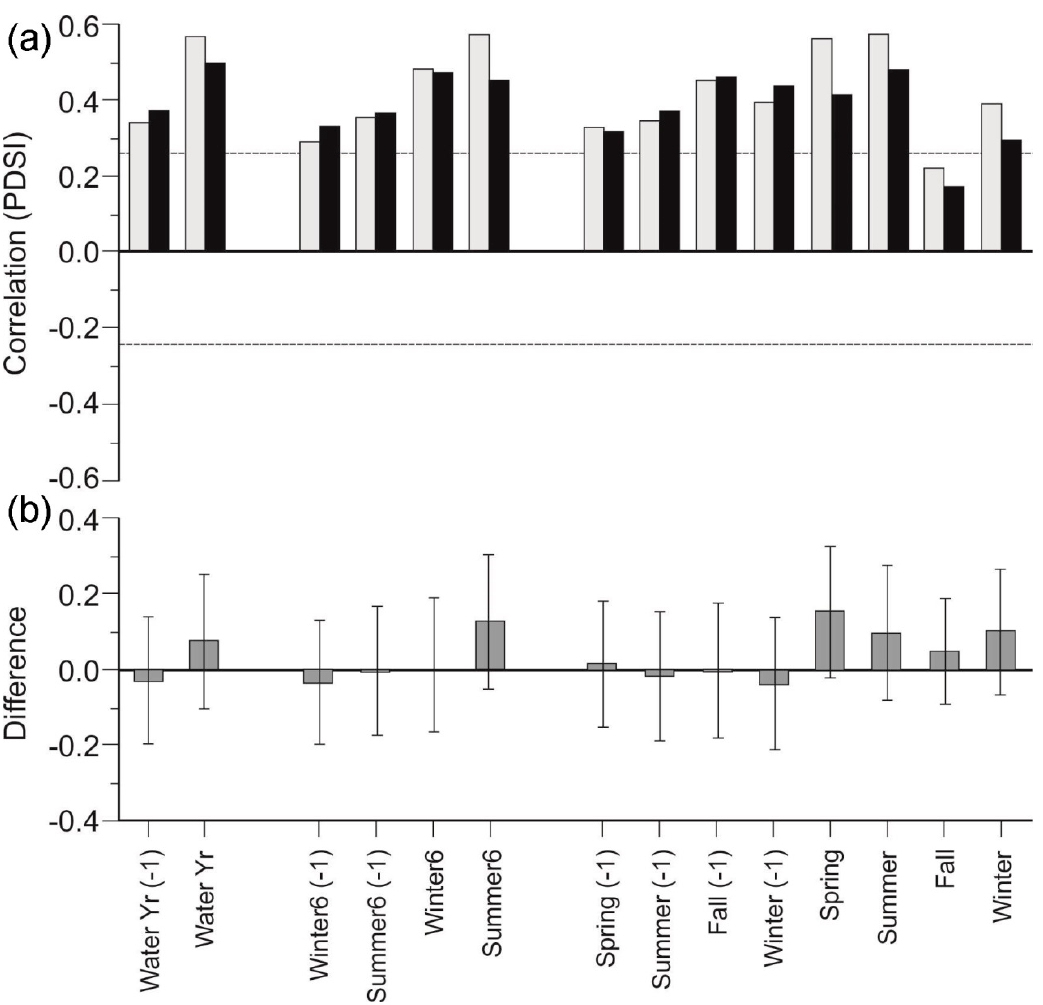
Figure 5. ( a ) Correlations between radial growth index of open-grown Douglas-fir (light gray) and closed-grown Douglas-fir (solid) and seasonal values of the PDSI (see text for time windows). Significance levels and confidence limits are indicated as in Figure 2. ( b ) Growth–climate response differences for the two chronologies. Positive values indicate that open-grown Douglas-fir are more positively correlated to the PDSI than closed-grown Douglas-fir during that season. The error bars indicate the 95% confidence limit on the difference.